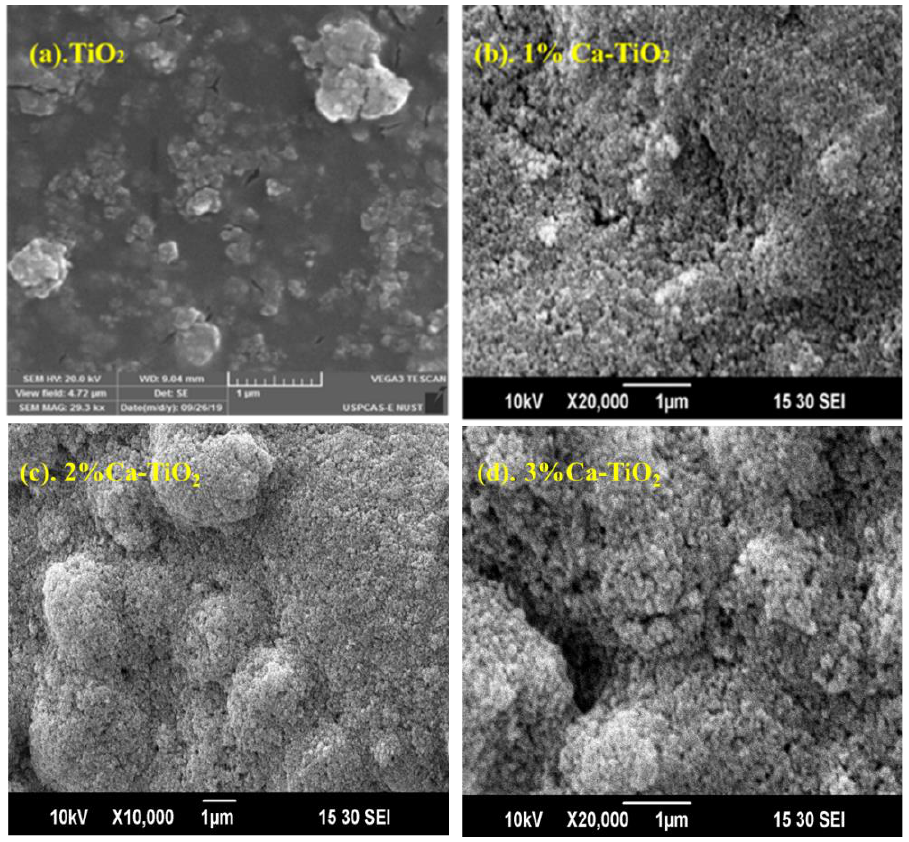
Figure 3. SEM micrographs of ( a ) TiO 2 , 1 μm ( b ) 1% Ca-TiO 2 , 1 μm ( c ) 2% Ca-TiO 2 , 1 μm and ( d ) 3% Ca-TiO 2 1 μm.